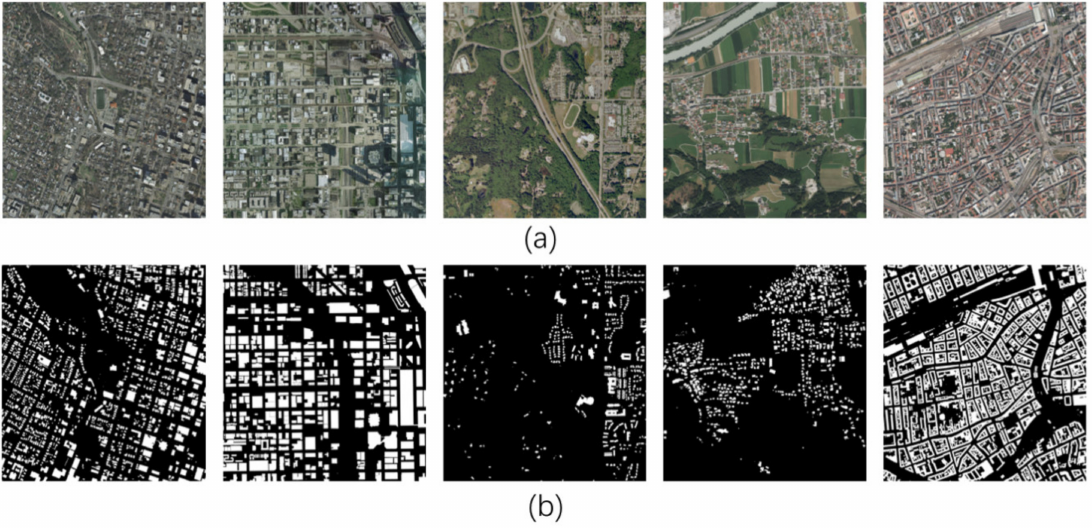
Figure 1. Examples from the Inria dataset, showing five sample image patches ( a ) and the corresponding ground truth ( b ) for Austin, Chicago, Kitsap County, Western Tyrol and